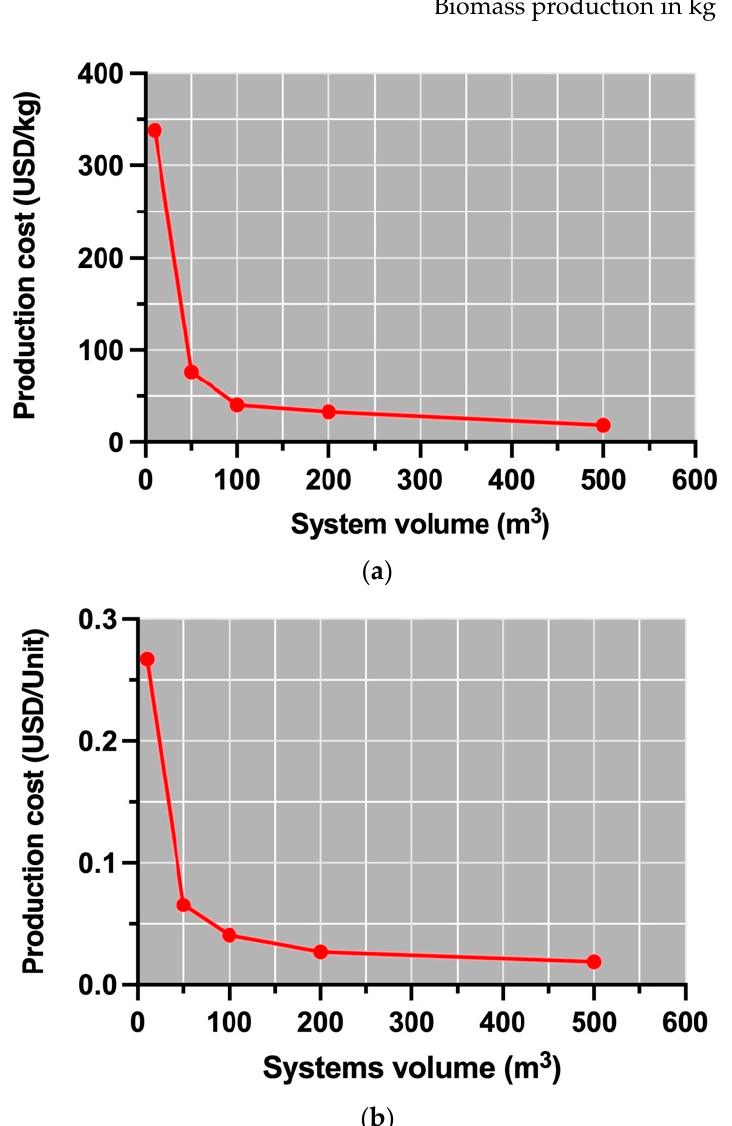
Figure 7. Production cost dependence on system volume for two scenarios of biomass production: ( a ) pelletized biomass and ( b ) live feed.